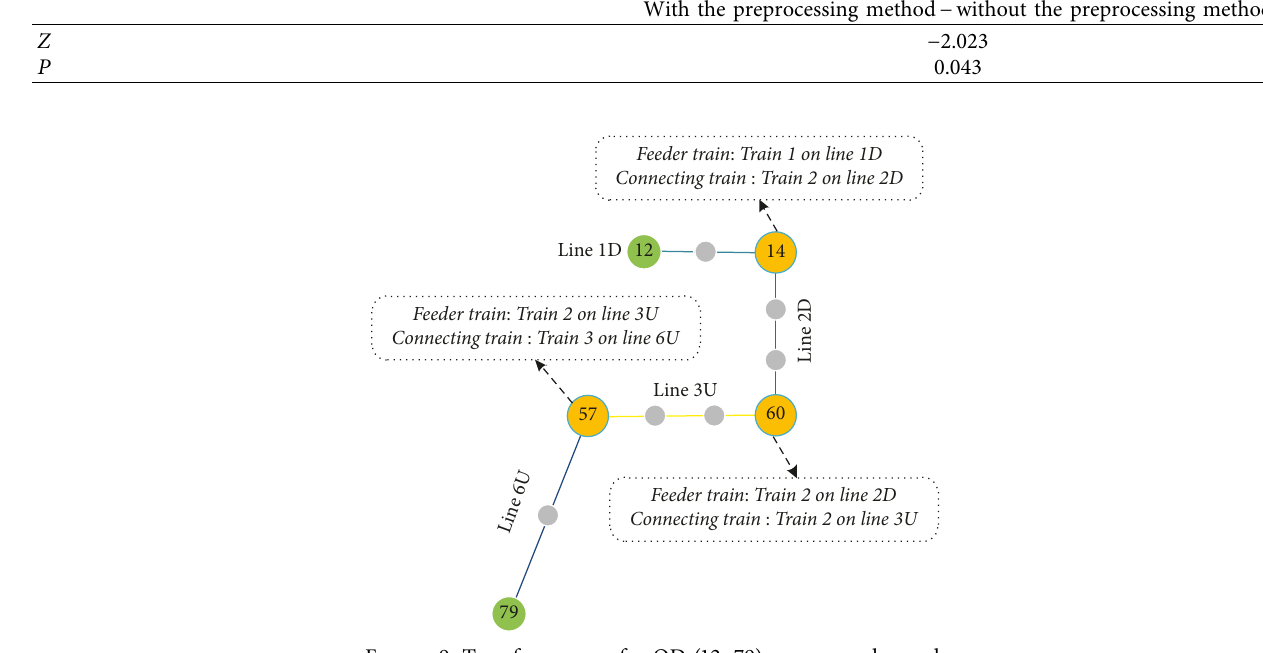
Figure 9: Transfer process for OD (12, 79) passenger demand.